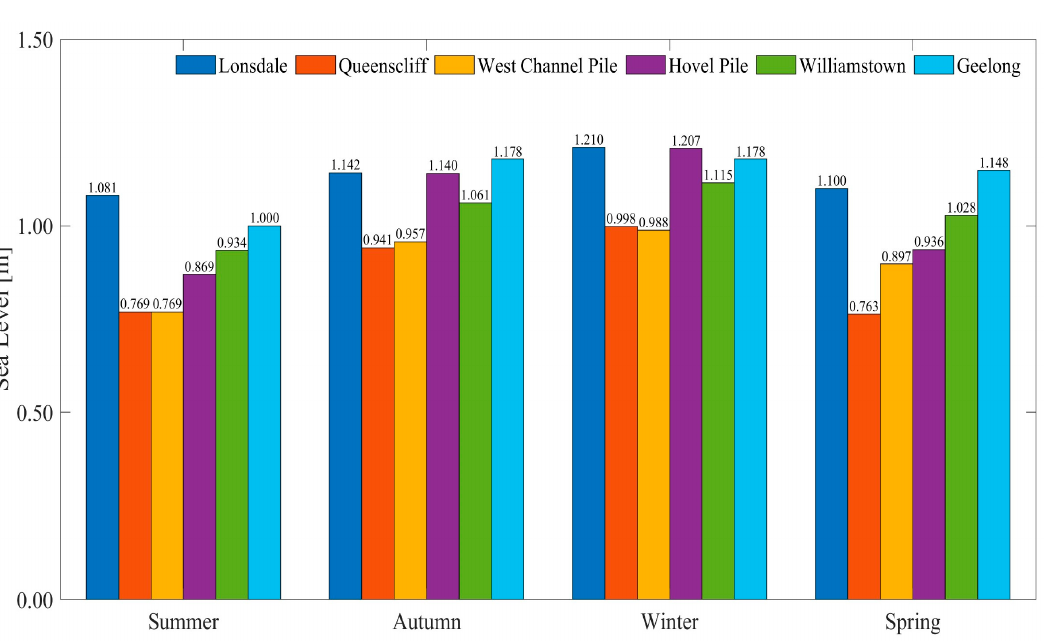
Table 2. Timing of largest “hourly water levels” at tidal gauges in PPB for different seasons. Station